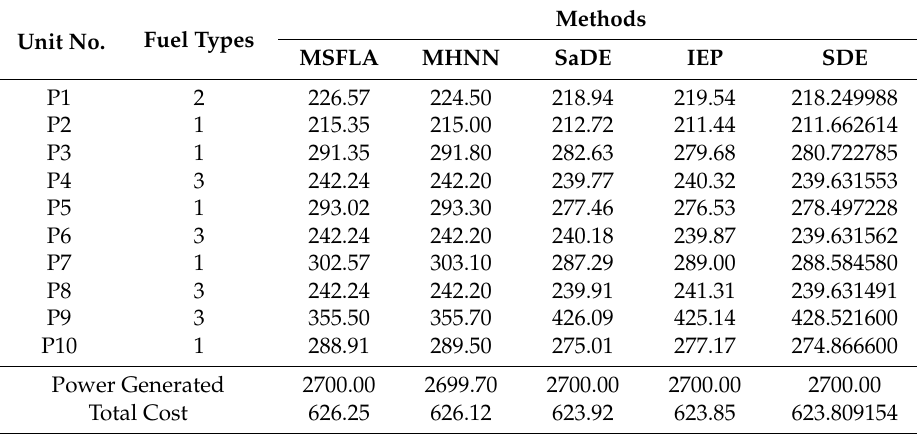
Table 1. Cost comparison among various methodologies for System 1, P d = 2700 MW.